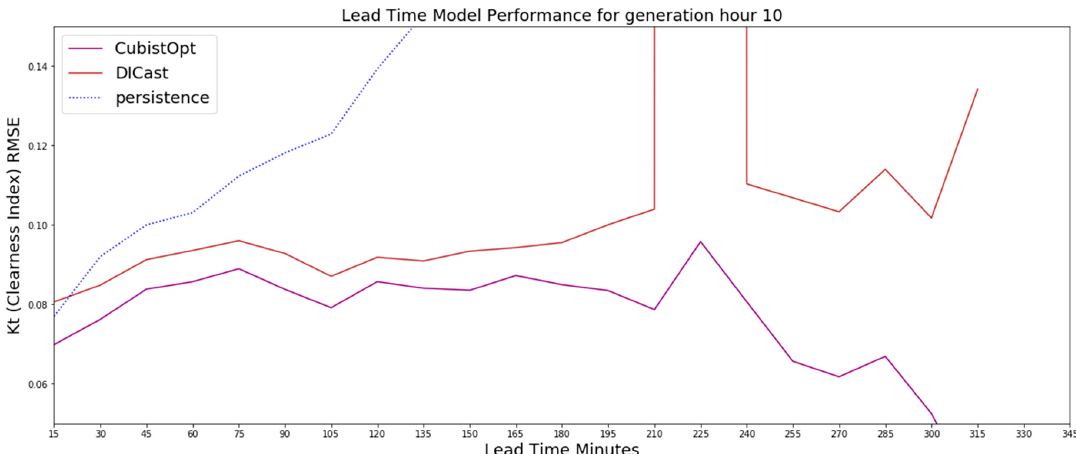
Figure A4. The 8 UTC generation time RMSE results on the test dataset for the CubistOpt method, the clearness index persistence and the DICast forecasts, which show that the CubistOpt (purple line) method has the lowest error over all time periods.